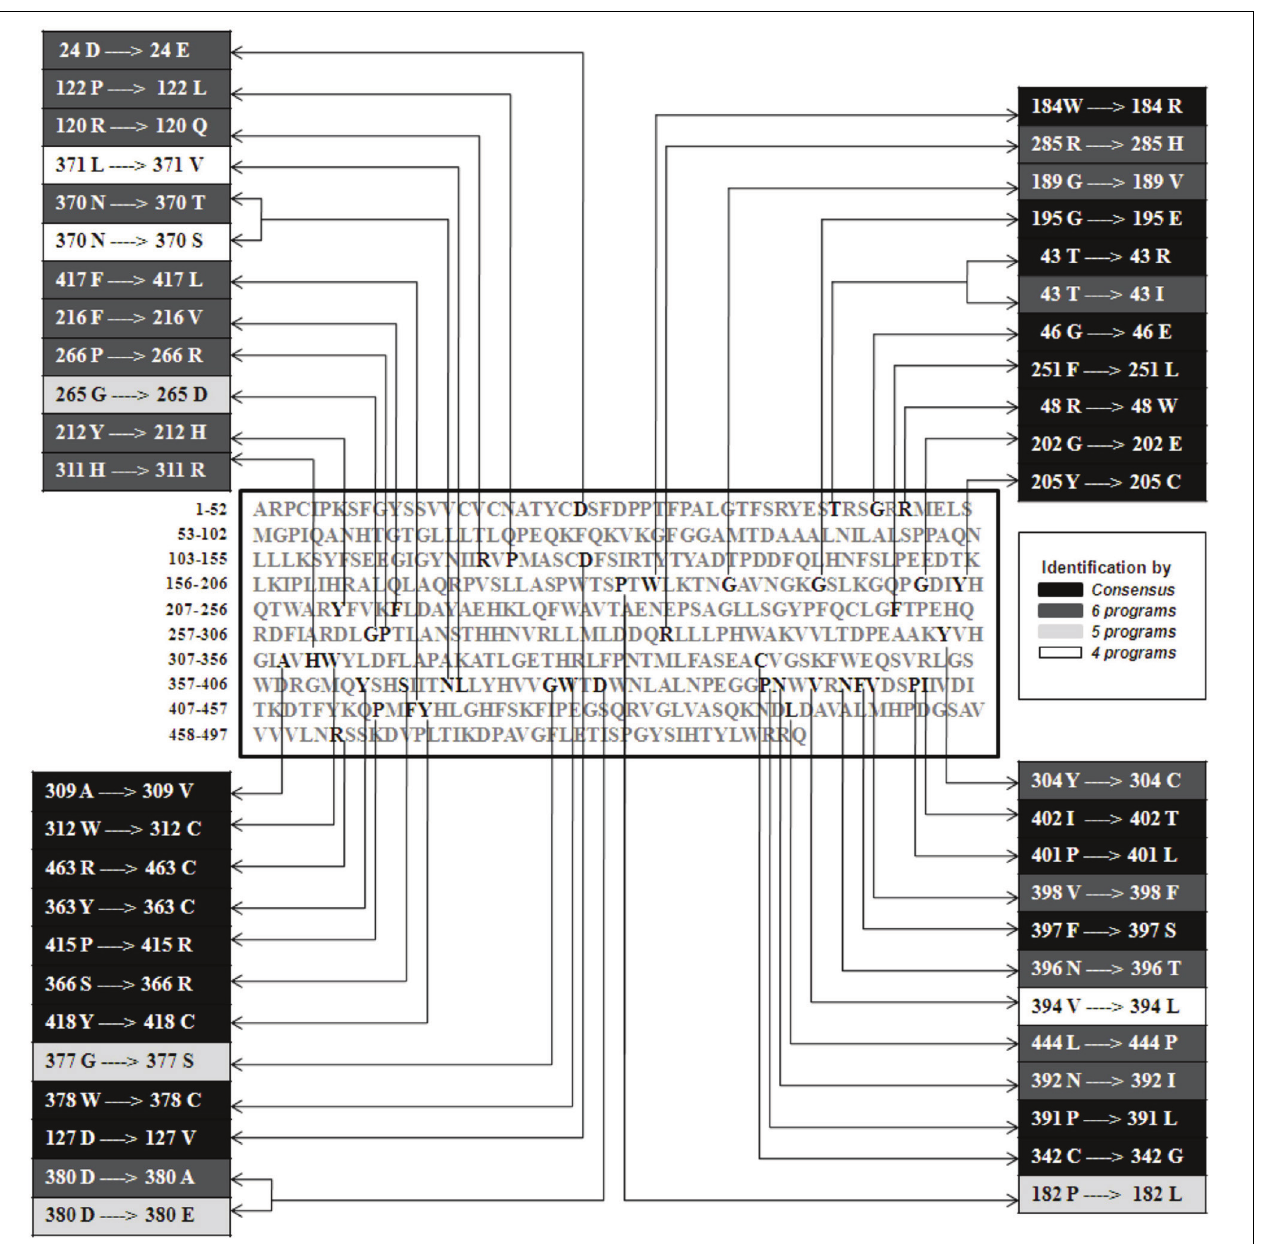
FIGURE 1 | Sets of various mutations identified using various software tools. The respective locations of 44 amino acids responsible for all 47 mutations are shown in the sequence (center, colored in bold) and 22 common mutations are highlighted as